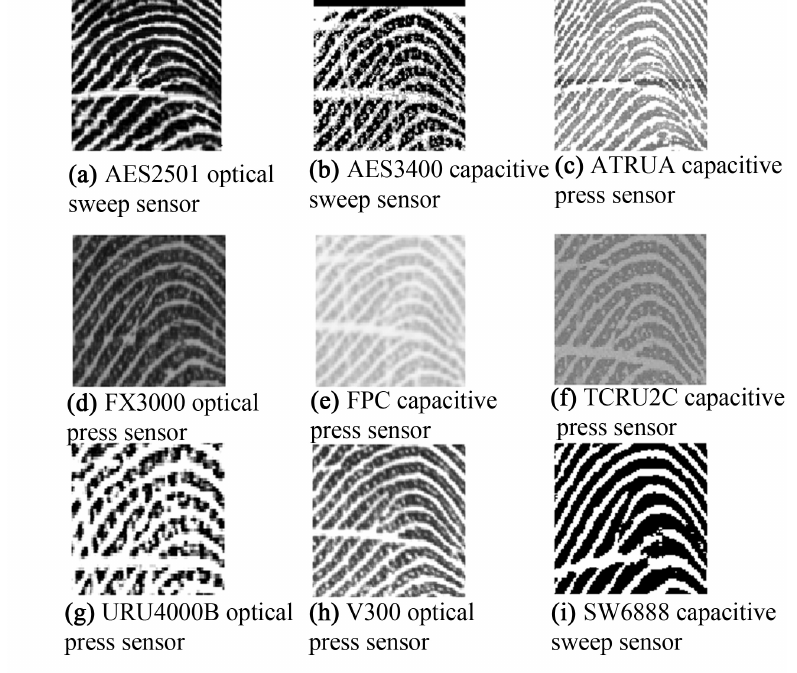
Figure 1. A zoomed-in view of fingerprints captured with different